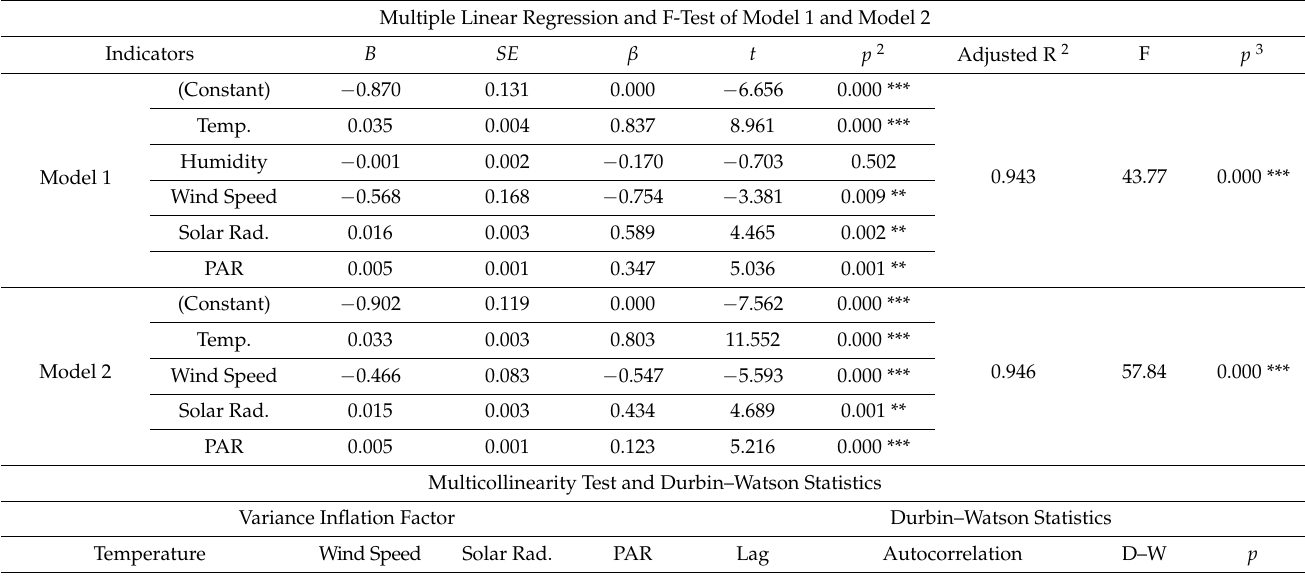
( B = − 0.466) results in lower TNVOC emissions. Among the independent variables of Model 2, temperature, wind speed, solar radiation, and PAR, temperature ( β = 0.803) was shown to have a greater effect on TNVOC emissions in the 1000/ha site. The regression equation of Model 2 for prediction of TNVOC emissions in the 1000/ha study site is shown below.